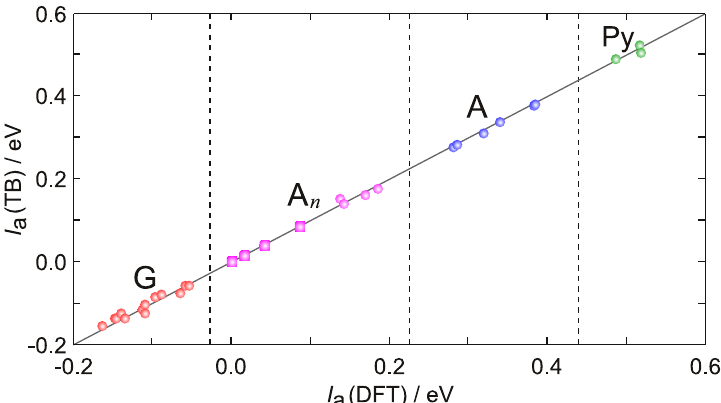
Figure 9. Comparison of adiabatic ionization energies (relative to XXGX, X being 6-azauracil) predicted by DFT (abscissa) and TB (ordinate) computations for tetrameric single stranded DNA oligonucleotides (circles). Hole energies for TA n T ( n = 3–6) sequences (squares) have been computed only at the TB level. Full line has null intercept and unitary slope. Dashed lines separate the regions of potential corresponding to the oxidation of G (red), A n tracts (violet), A (blue) and pyrimidines (green). Very similar oxidation patterns were found by differential pulse voltammograms recorded in buffered aqueous solutions for single and double stranded DNA oligonucleotides and DNA itself (see Refs. [47,59,124,125]). Reproduced from Ref. [62] with permission from the PCCP Owner